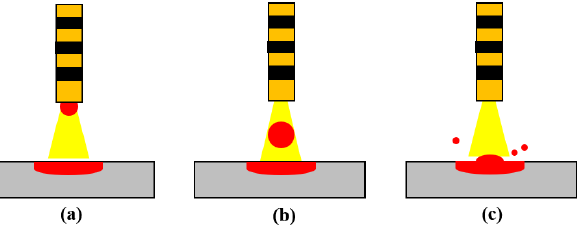
Figure 6. The schematic diagram of the spray transfer mode: ( a ) initial stage, ( b ) process stage, ( c ) final stage.